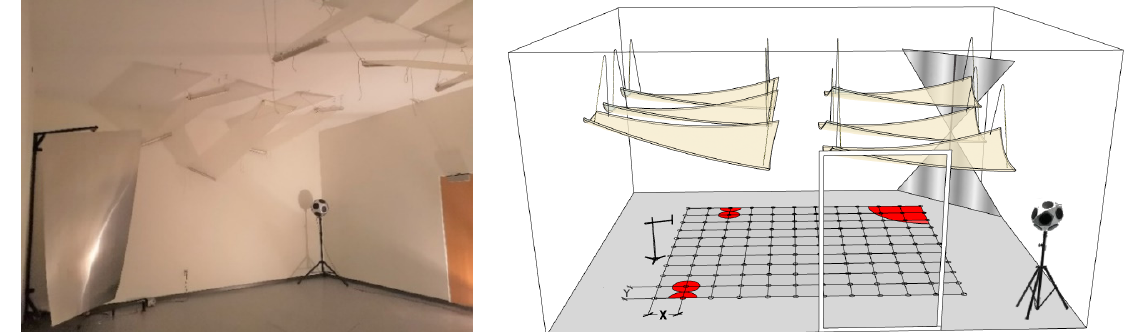
Figure 2. Left : A picture of the experimental setup in the reverberation room in Concordia Acoustics Lab. Right : A 3-D model of the reverberation chamber. The diffusers hanging from the ceiling are indicated in light yellow. A steel rotating diffuser is located near the upper-right corner. The measurement grid spacing (X, Y) is 40 cm.